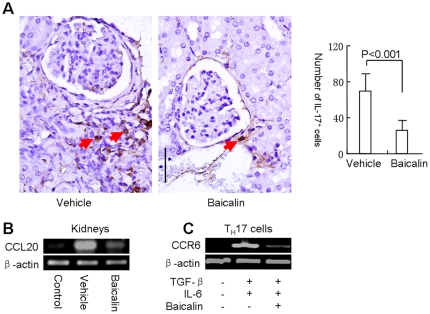
Baicalin inhibits IL-17+ lymphocyte infiltration into kidney.(A) IL-17 immunohistochemical staining in kidneys from MRL/lpr mice treated with Baicalin or vehicle for 9 weeks, arrow shows the typical IL-17+ lymphocytes. Scale bar, 100 µm. Five independent microscopic fields were selected randomly for each sample to ensure representativeness and homogeneity. Right panel shows the IL-17+ cells counted under ×100 magnification. (B) CCL20 mRNA expression in kidney. (C) CD4+CD25− T cells from B6 mice were cultured under TH17 conditions with or without Baicalin for 3 days, CCR6 mRNA expression in TH17 cells was examined by RT-PCR. These experiments were performed three times with similar results.